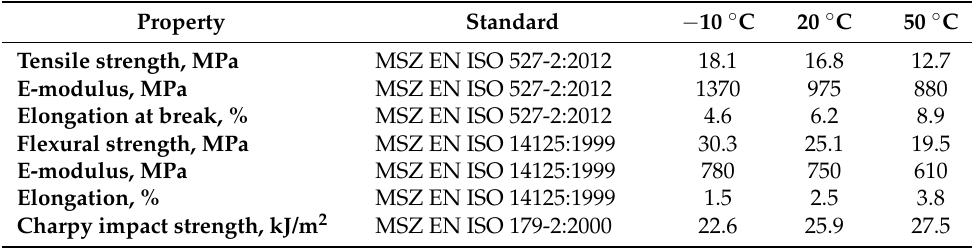
Table 1. The main properties of the used